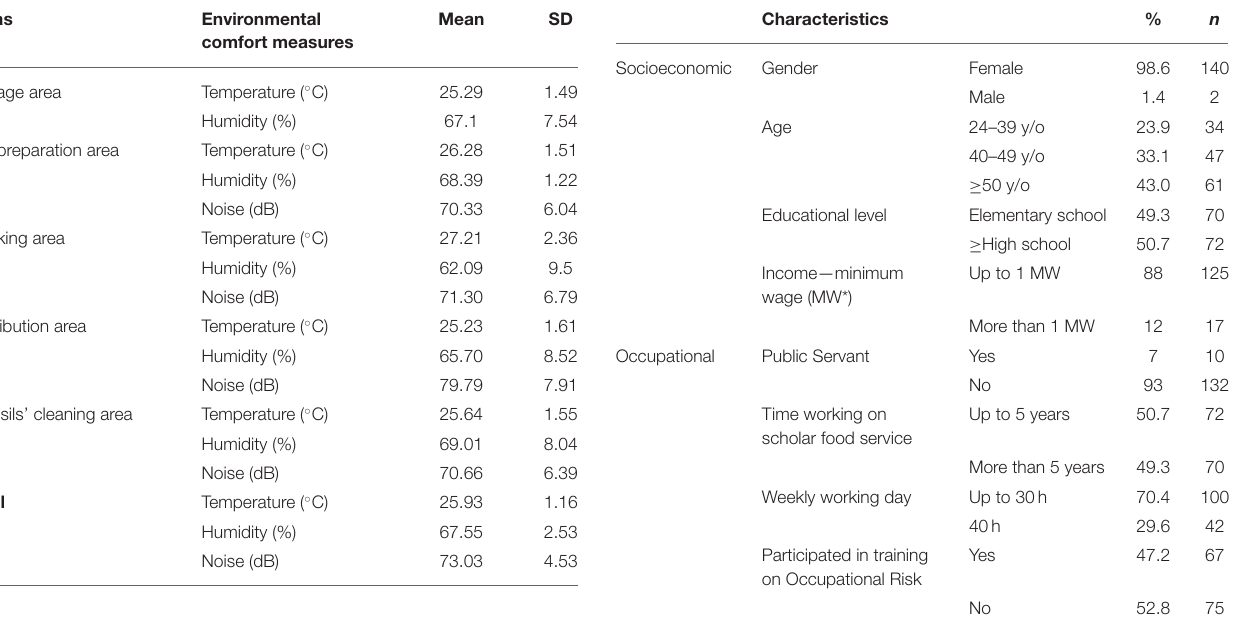
TABLE 3 | In percentages and numbers, the sociodemographic and occupational characteristics of food handlers (Bahia/Brazil).